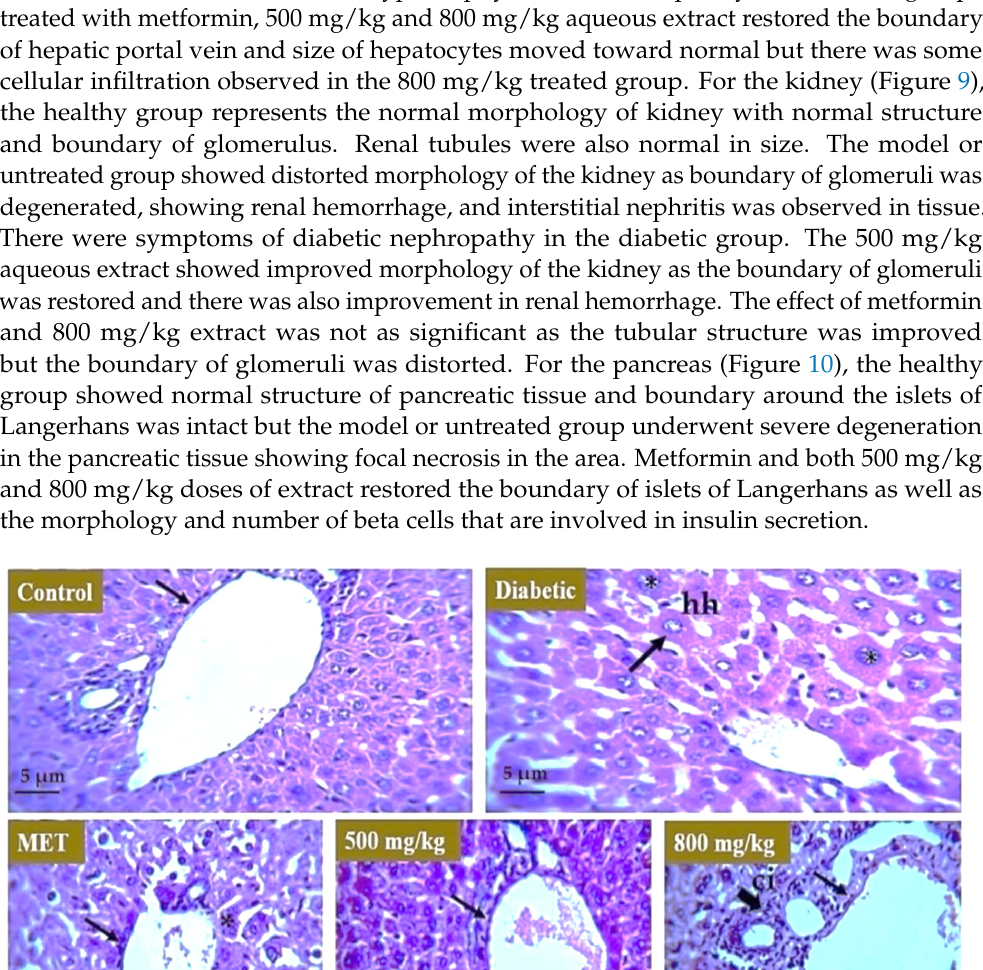
Figure 9. Effect of aqueous extract on the kidney. The kidney of the normal mice revealed intact glomeruli and tubular structure. The kidney of diabetic mice showed interstitial nephritis and renal hemorrhage (arrows). Metformin-treated mice showed little improvement in interstitial nephritis